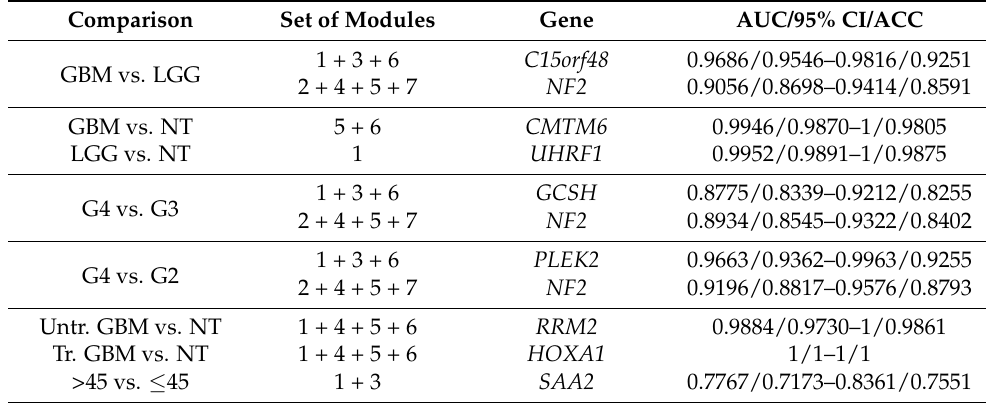
Table 2. Post-validation significant comparisons with the best explanatory gene.